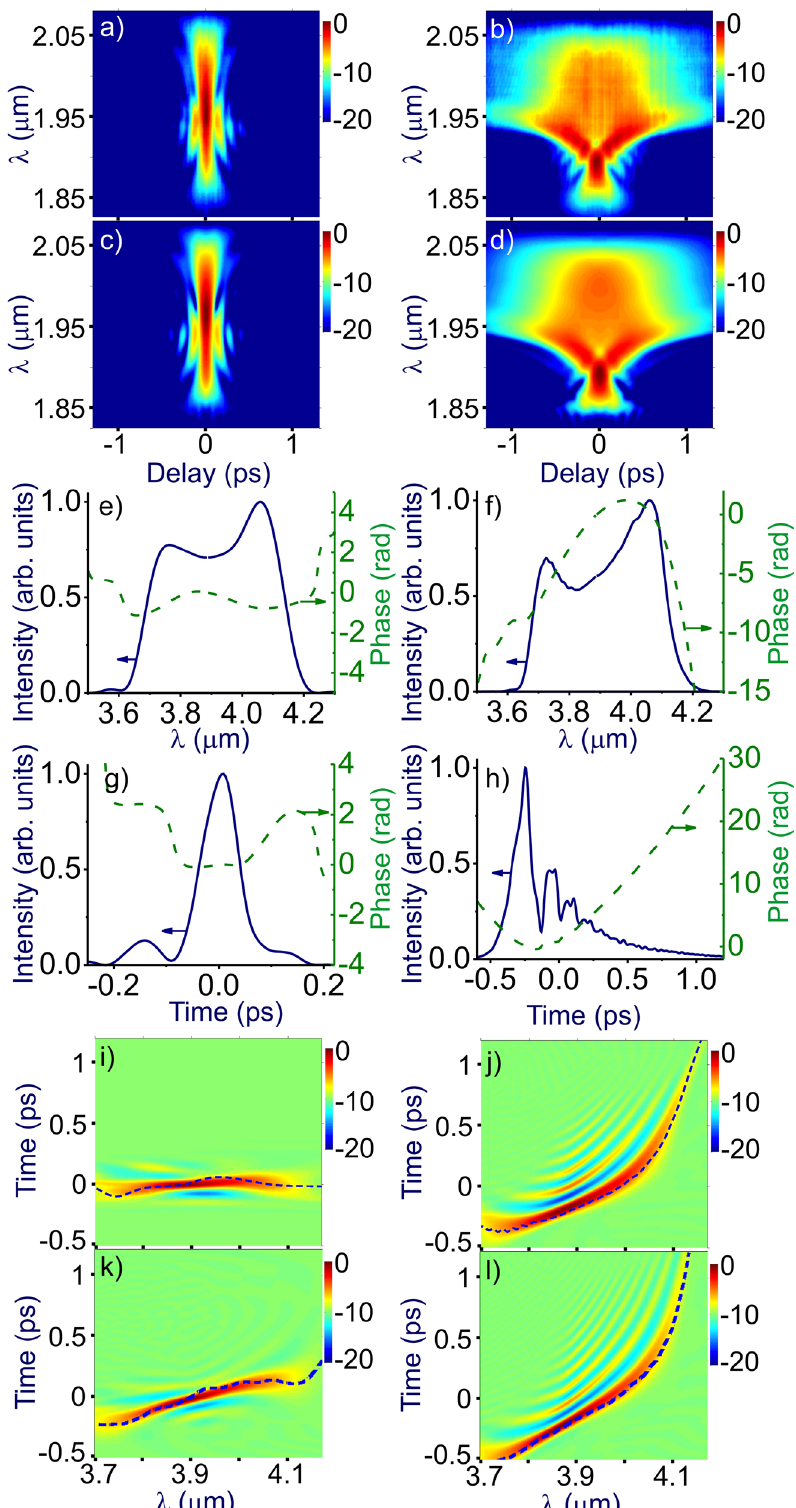
Figure 3. ( a–d ) Measured ( a,b ) and reconstructed ( c,d ) FROG traces of the OPCPA output ( a,c ) and the laser probe transmitted through 60 m in atmospheric air ( b,d ), ( e,f ) spectra (solid lines) and spectral phases (dashed lines), ( g,h ) temporal envelopes (solid lines) and phases (dashed lines) retrieved from the FROG traces of the OPCPA output ( e,g ) and the laser probe transmitted through 60 m in atmospheric air ( f,h ), ( i,j ) Wigner spectrograms of the OPCPA output ( i ) and the mid-IR laser probe transmitted through 60 m in atmospheric air ( j ). ( k,l ) Wigner spectrograms of the mid-IR probe with an initial chirp of − 0.007 ps 2 at the OPCPA output ( k ) and behind the 60-m delay line ( l ). The group delay is shown by the dashed line in the Wigner